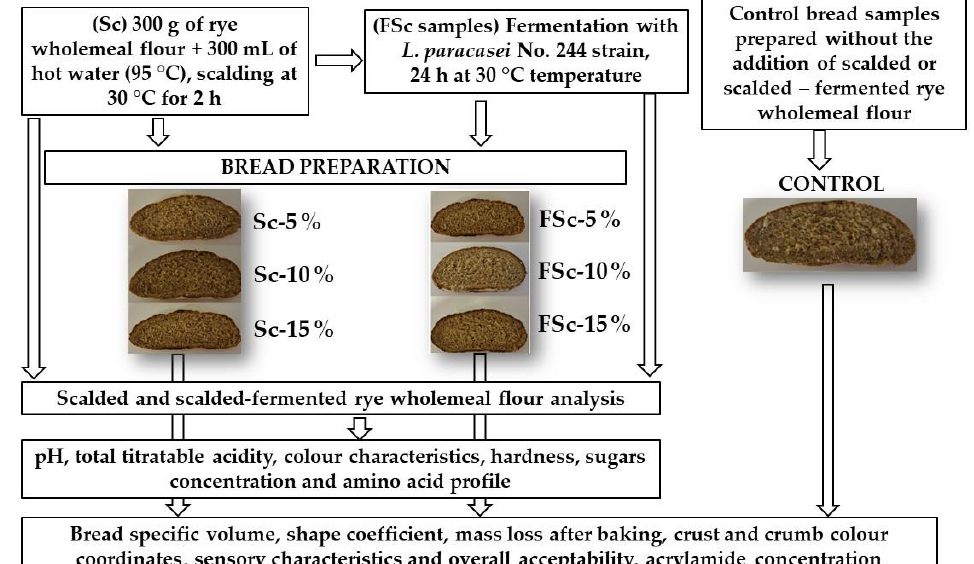
Figure 1. Schematic representation of the experimental design.